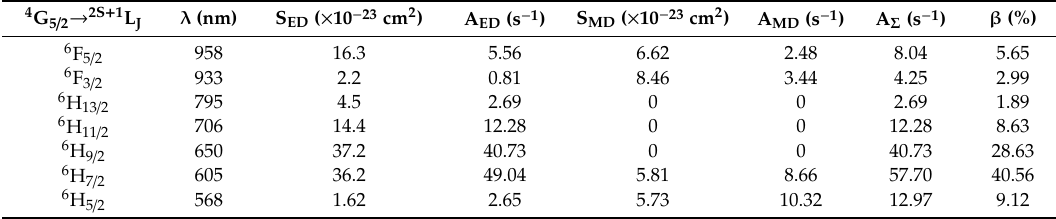
Table 1. Parameters of luminescence of samarium complex 4 in THF